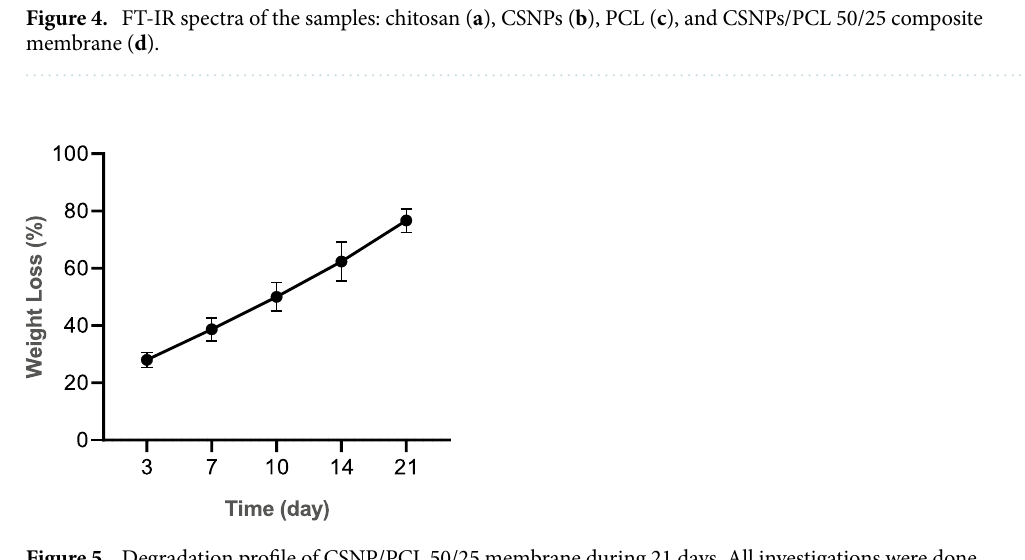
Figure 5. Degradation profile of CSNP/PCL 50/25 membrane during 21 days. All investigations were done triplicate (n = 3) in PBS (pH = 7.4) at 37 °C. Data was represented as mean ±